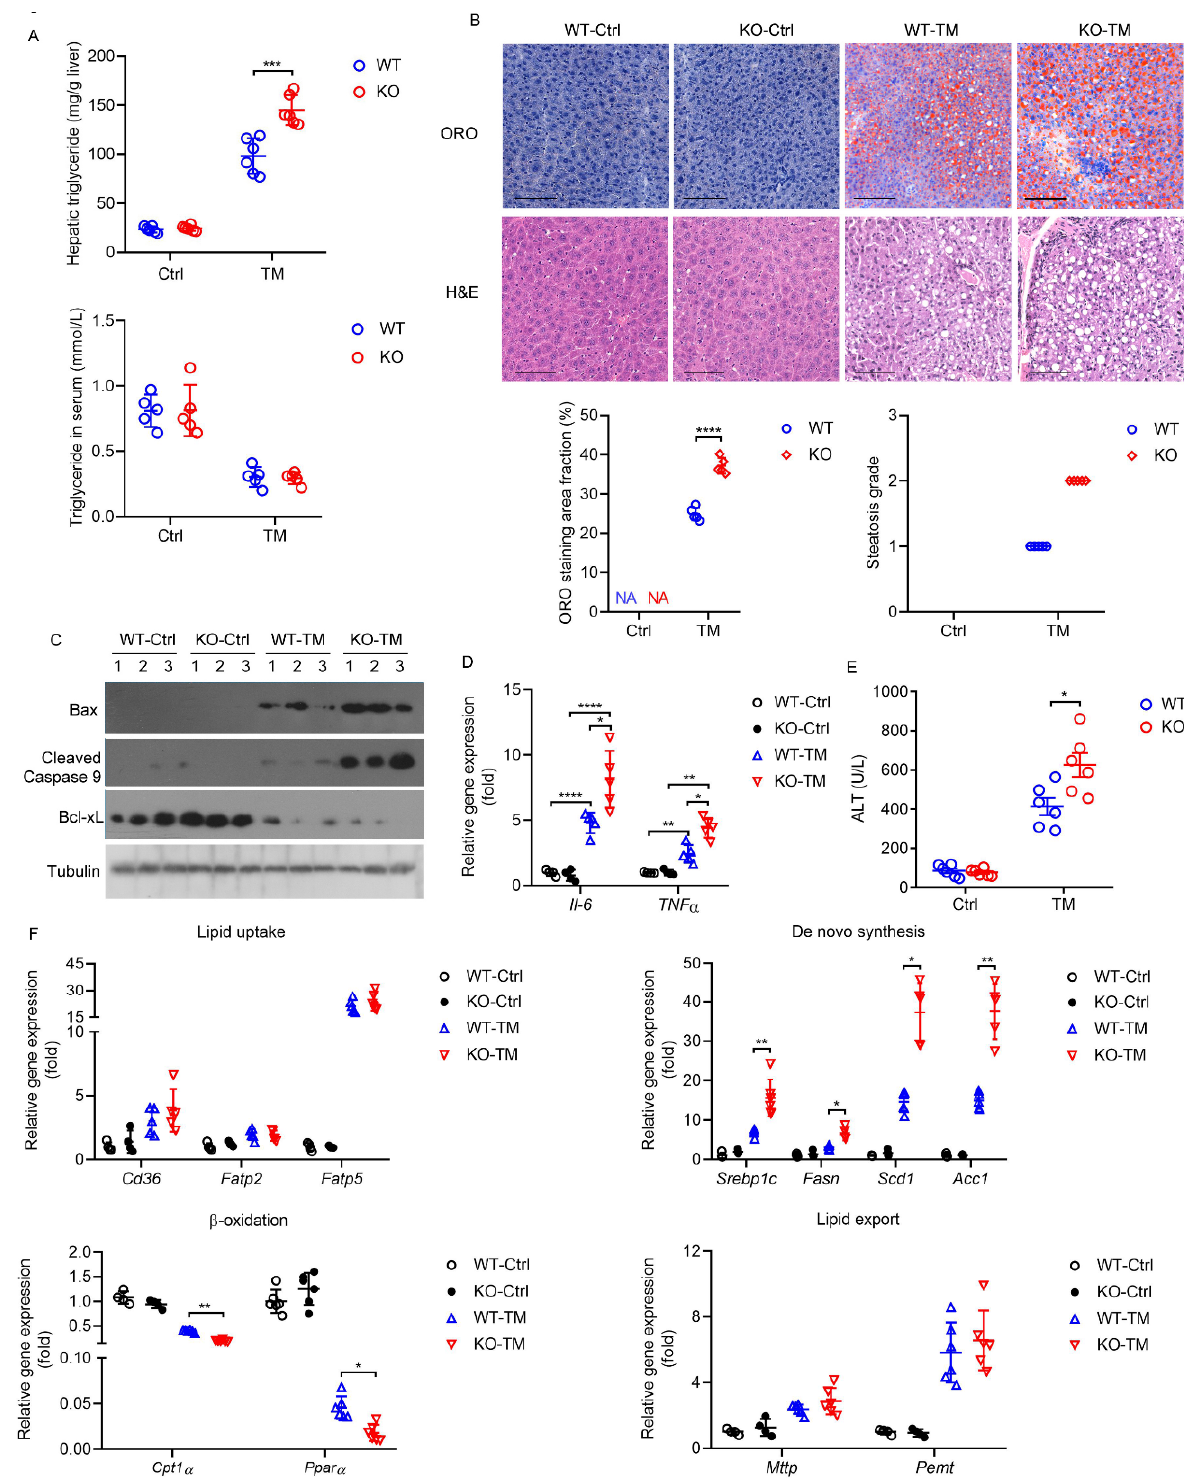
Figure 6. HPS-KO mice show aggravated TM-induced hepatic steatosis. Eight-week-old WT and HPS-KO mice were injected intraperitoneally with TM (1 mg/kg body weight) for 24 h. ( A ) Hepatic and serum triglyceride levels of the mice ( n = 5–6). ( B ) Representative images of ORO- and H and E-stained liver sections of the mice ( n = 6). Scale bar = 100 μ m. The ORO staining area fraction was quantitated using ImageJ software and values are the mean ± SD of 5 liver sections of measurements. The steatosis grade was evaluated according to steatosis area fraction. <5%, score 0; 5–33%, score 1; 33–66%, score 2; >66%, score 3. ( C ) Immunoblotting analysis of protein levels of Bax, cleaved Caspase 9 and Bcl-xL in mice liver. Arabic numeral represents the number of the mouse to which the protein sample belongs in each group. ( D ) Relative expression of Il6 and Tnf α mRNA in mice liver was measured ( n = 4–6). ( E ) Serum ALT levels of the mice ( n = 6). ( F ) Relative expression of Cd36 , Fabp2 , Fabp5 , Srebp1c , Fasn , Scd1 , Acc1 , Mttp , Cpt1 α and Ppar α mRNA in mice liver was measured ( n = 4–6). Data are expressed as mean ± SD of all samples for each group. The significant